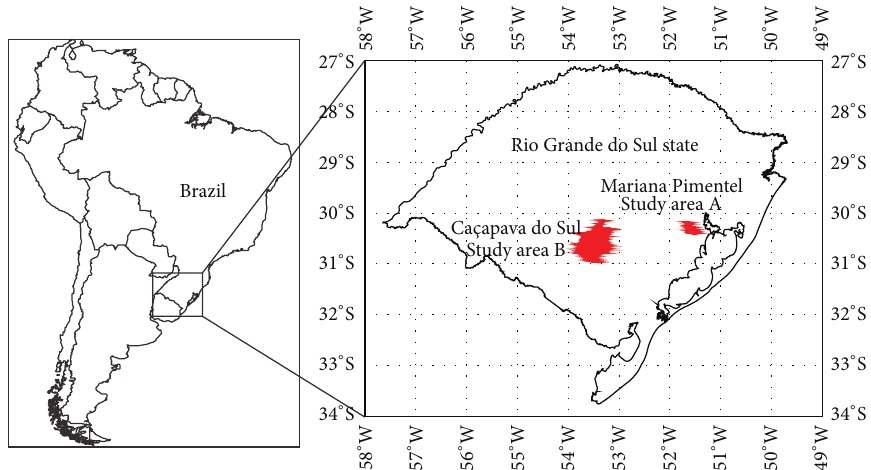
Figure 3: Localization of the study areas in Mariana Pimentel (A) and Cac¸apava do Sul (B).